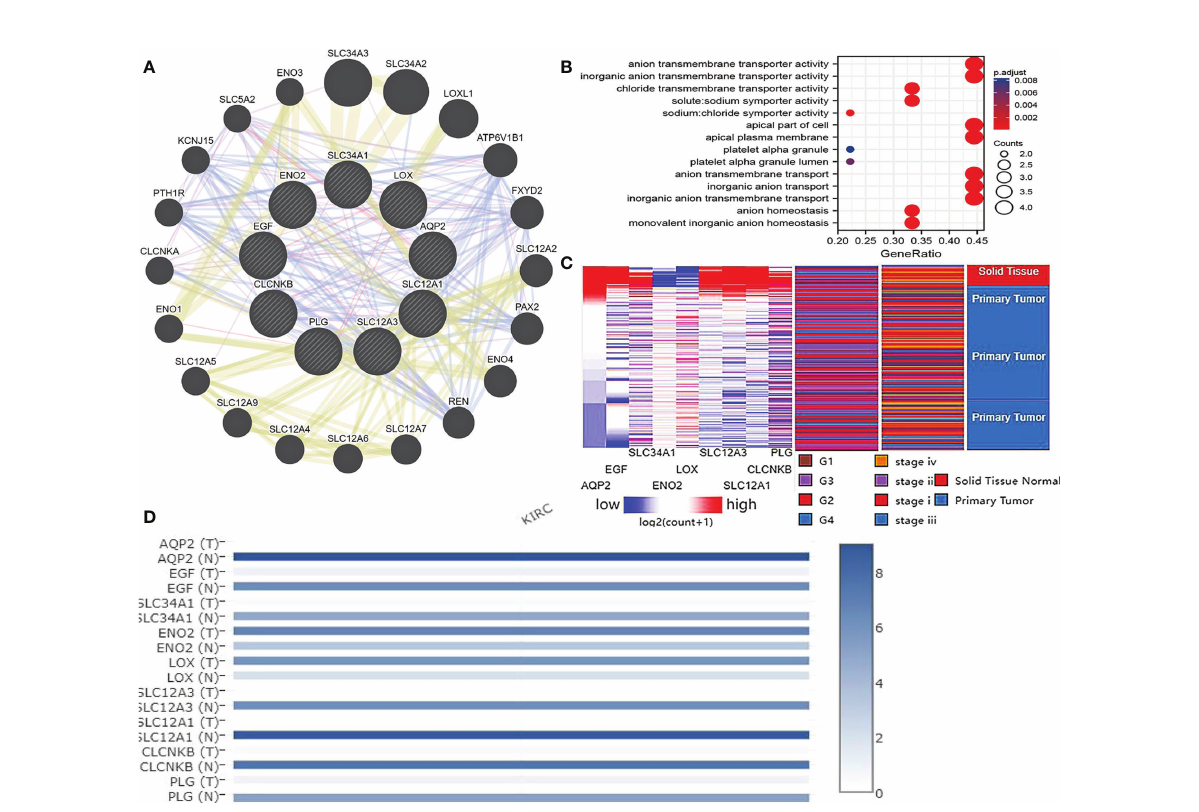
FIGURE 3 (A) coexpression analysis of hub genes. Blue line: Co-localization, Purple line: Co-expression, Yellow line: Shared protein domains, Red line: Physical Interactions. (B) Hub gene enrichment analysis results. (C) Hierarchical clustering of hub genes was constructed using UCSC. Red represents up- regulation, while blue represents down-regulation. (D) Expression of hub genes in ccRCC tissue samples and non cancer tissue samples.